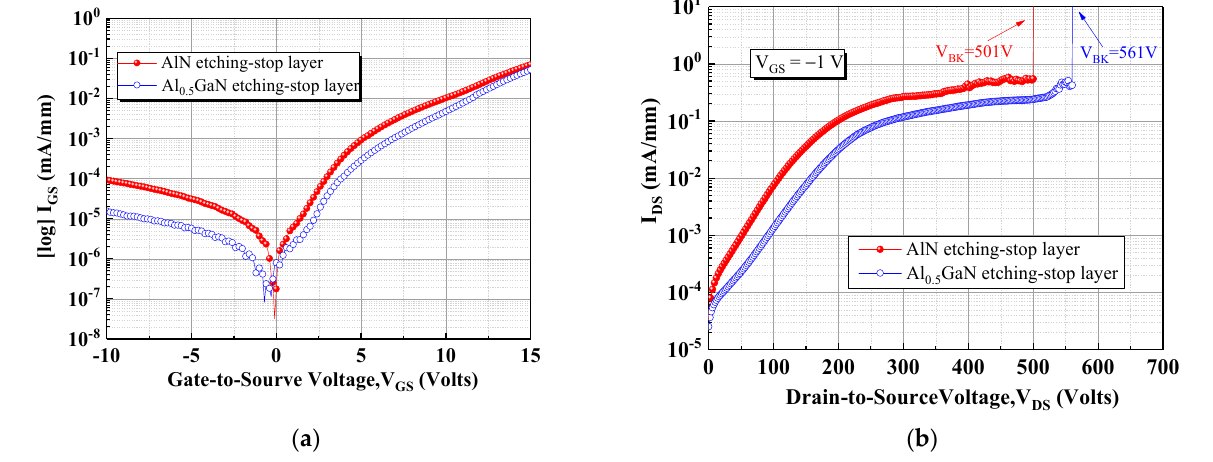
Figure 4. ( a ) Gate leakage characteristics and ( b ) off-state breakdown voltage measurement of both